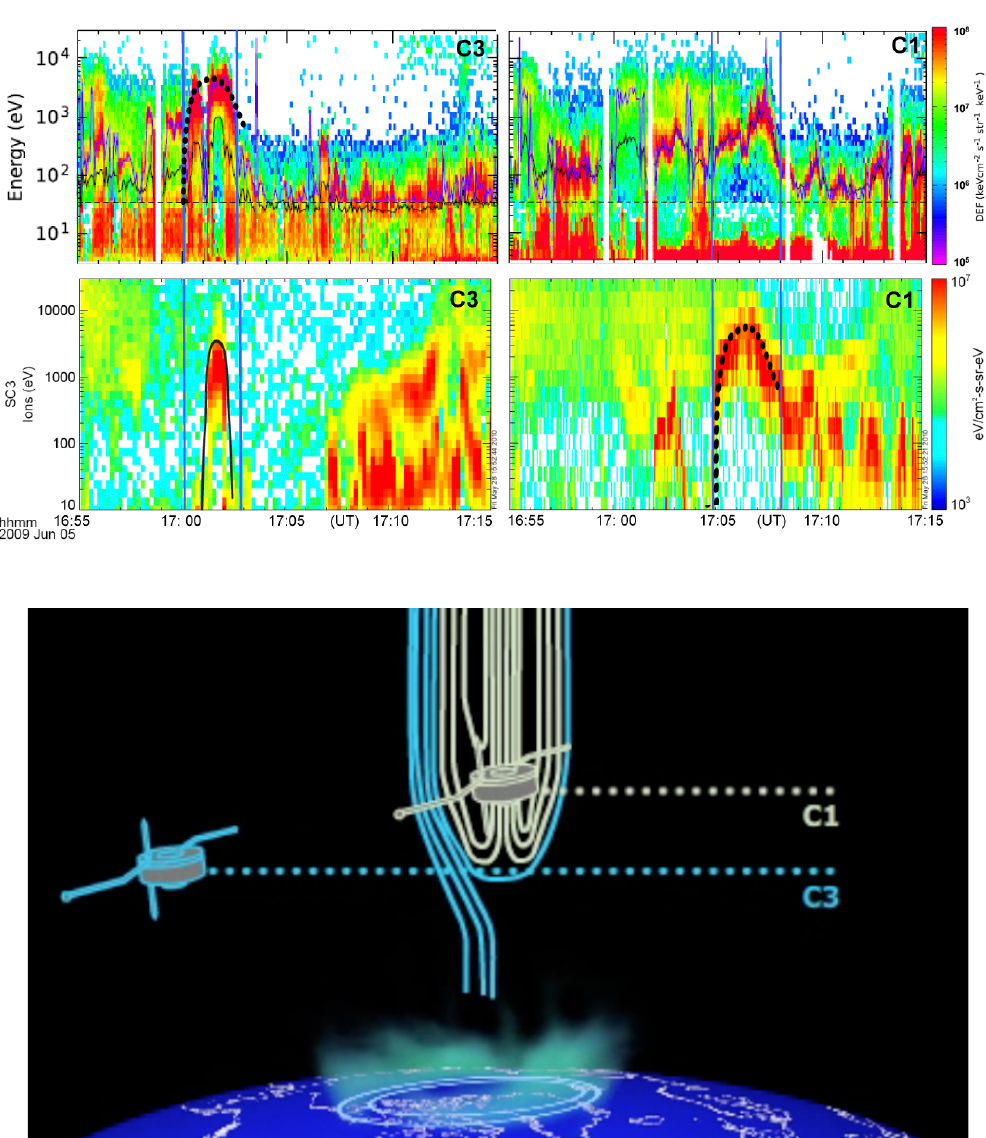
Fig. 11. Top: Electron and ion spectrograms during an AAR crossing with C3 and C1. C1 and C3 follow each other with C3 leading by Figure 11. (top) Electron and ion spectrograms during an AAR crossing with C3 and C1. C1 4 5min (adapted from Marklund et al., 2011). (bottom) Sketch of the AAR potential drop seen by C3 (blue) “S-shape” and C1 (blue and white) and C3 follow each other with C3 leading by 5 minutes (adapted from Marklund 2011). 5 (bottom) Sketch of the AAR potential drop seen by C3 (blue) ‘S-shape’ and C1 (blue and 6 white) ‘U-shape’. 7